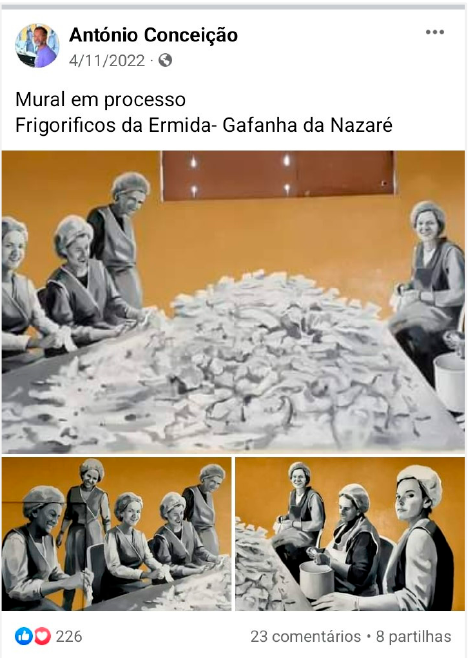
Figure 11. Member inquiring about the authorship of a work (Source: Facebook group Vizinhos de Aveiro/Aveiro Neighbors).